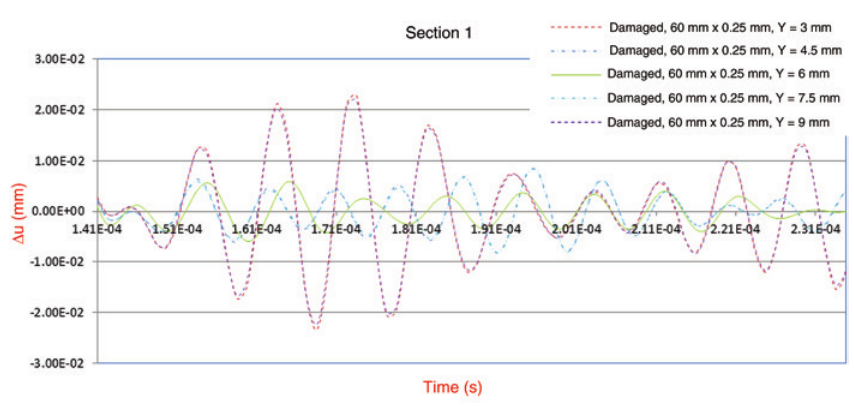
Figure 24: Time domain response at Section 1 with varying damage depth.